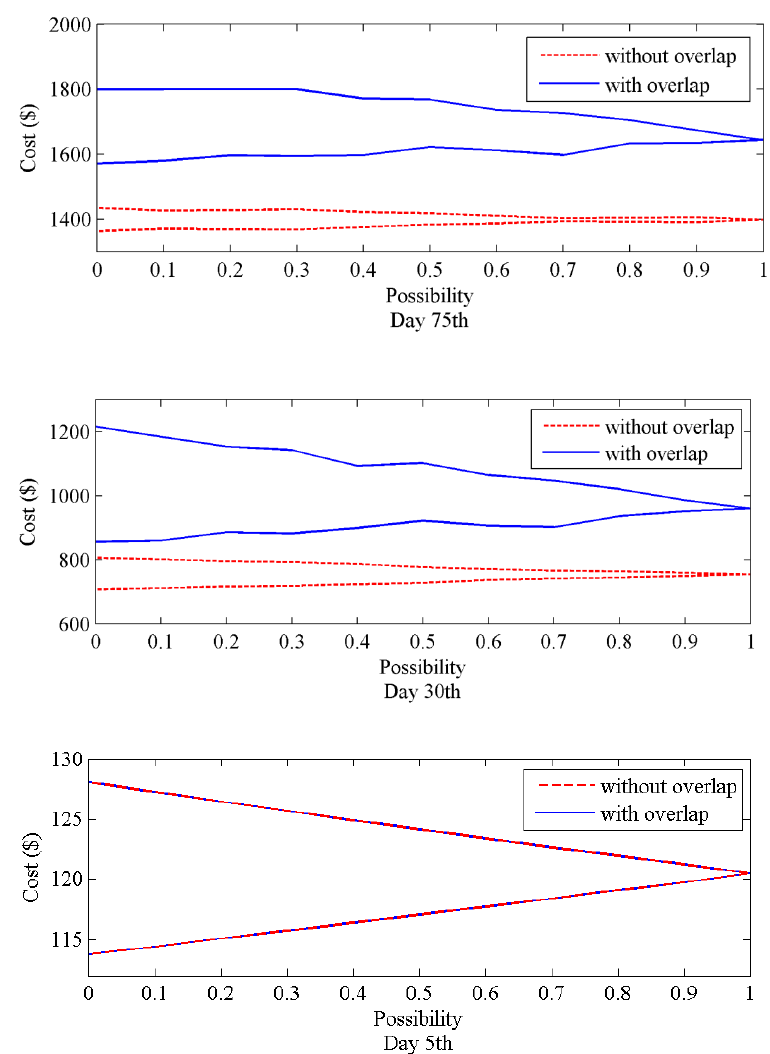
Fig. 16. S-surface cross-section at three time periods without and with task